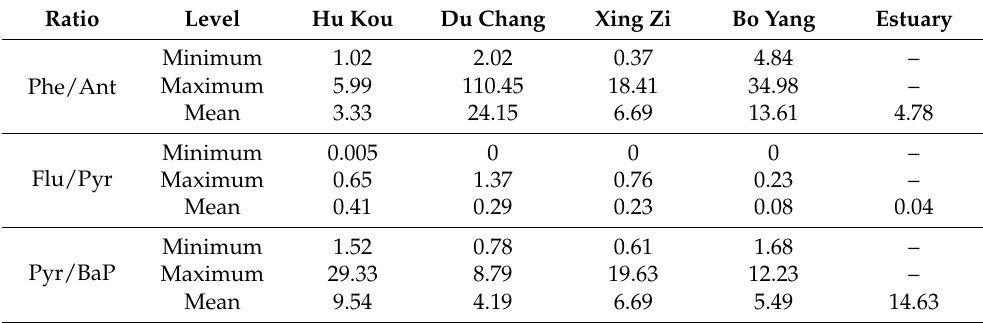
Table 4. Ratios of traceable characteristic compounds in the sampled counties in the Poyang Lake District,